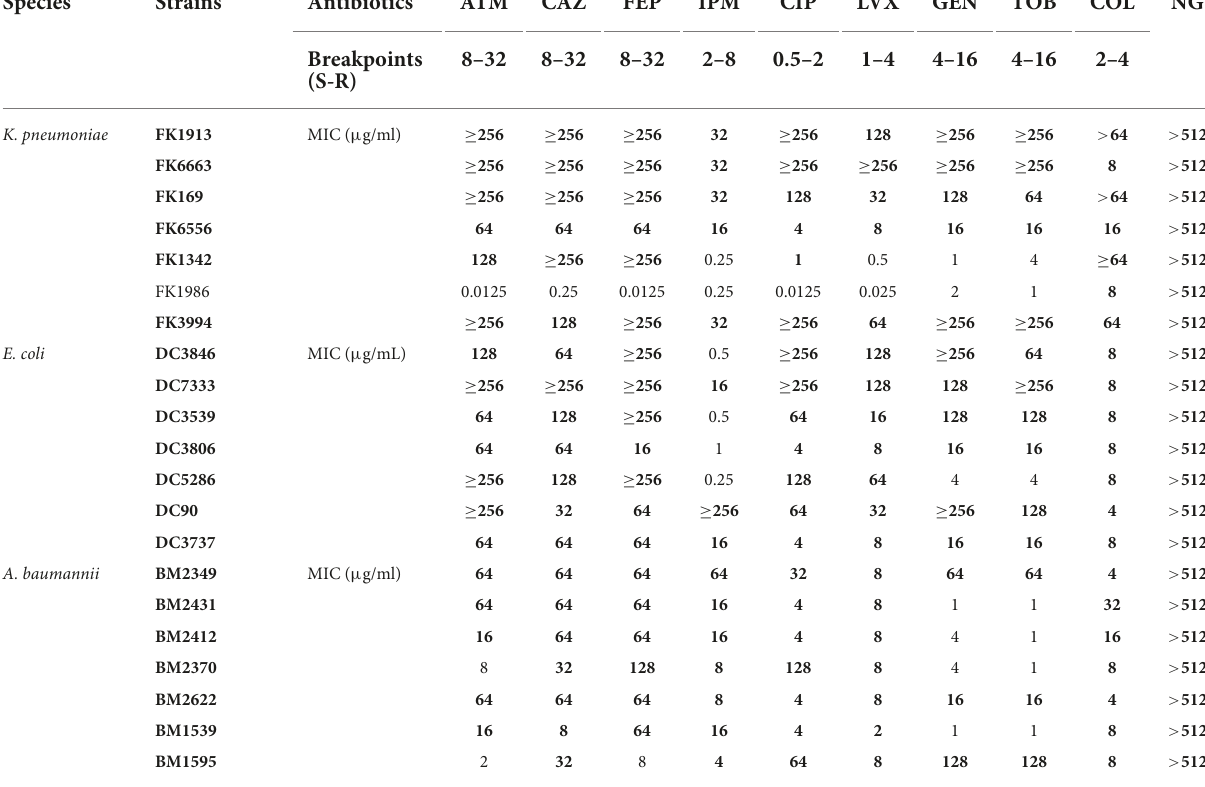
TABLE 1 Minimum inhibitory concentration (MIC) values of commonly used clinical antibiotics and NG against 21 colistin-resistant GNB. Species